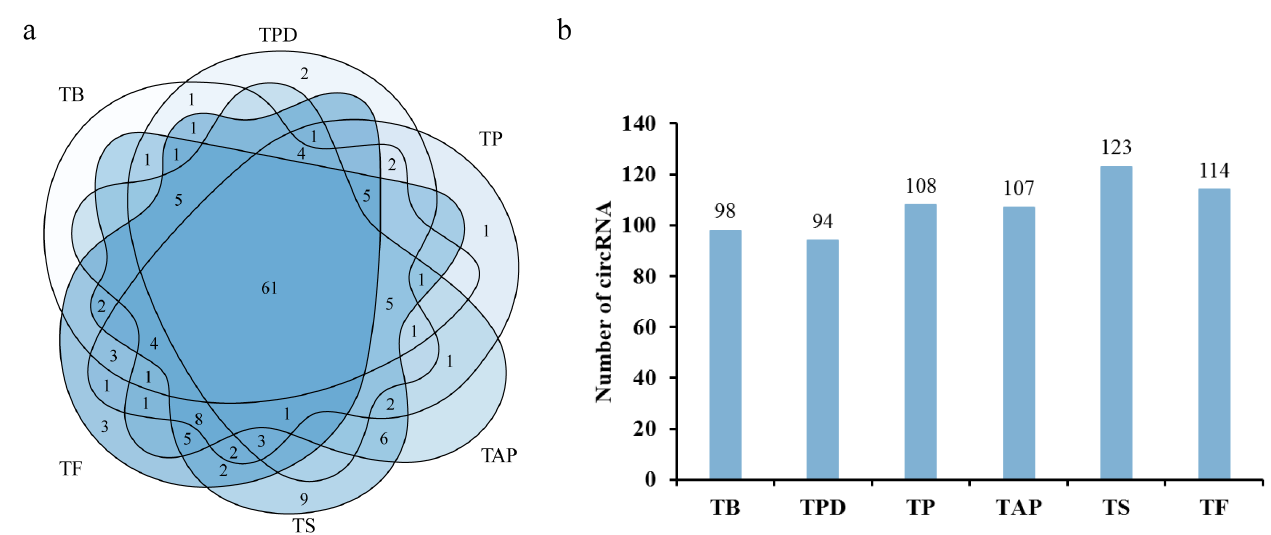
Figure 2. The distribution of circRNAs in different stages: ( a ) a Venn diagram showing the number and distribution of detected circRNAs in six stages; ( b ) histogram shows the number of circRNAs detected in each stage. TB: the time of bud stage; TPD: pollen dehiscence stage; TP: pollination stage; TAP: after pollina-tion stage; TS: senescence stage; and TF: fading TAP: after pollina-tion stage; TS: senescence stage; and TF: fading stage.